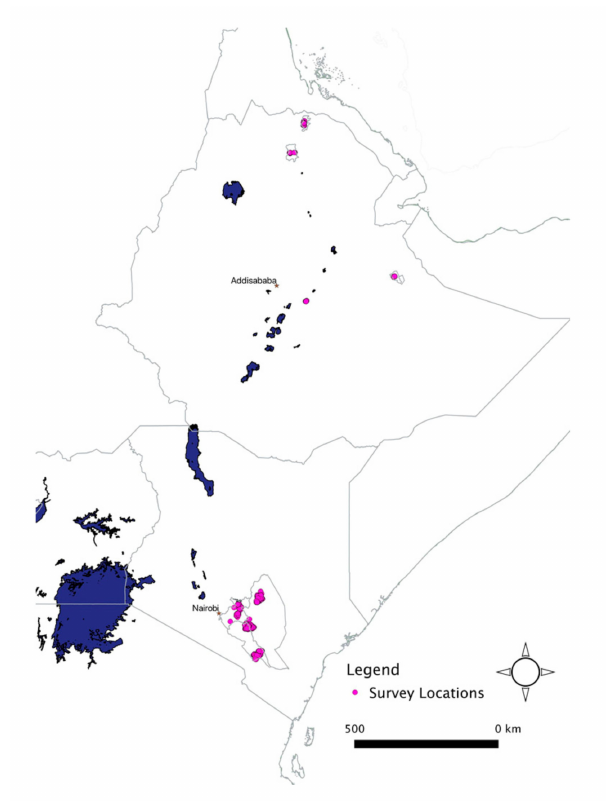
Figure 1. Map of the study locations in Ethiopia and